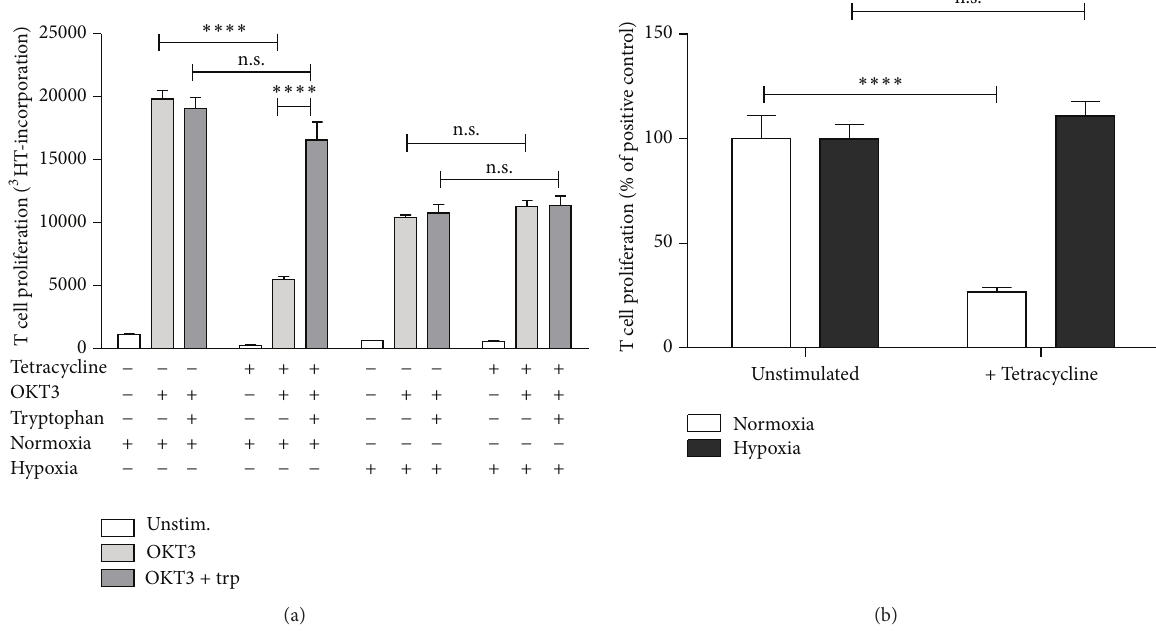
Figure 6: Loss of TDO immunoregulatory function in HeLa-hTDO cells under hypoxic conditions. T cell proliferation experiments: HeLa- hTDO cells were prestimulated with or without tetracycline (10ng/mL) for 72 h under normoxia (20% O 2 ) or hypoxia (1% O 2 ). Then the supernatants were harvested and served as cell culture medium for freshly isolated peripheral blood lymphocytes (PBL). 1.5 × 10 5 PBL/well were activated in 96-well plates with a monoclonal anti-CD3 antibody (OKT3) and T cell proliferation was determined after three days by adding 3 H-thymidine for 24 h. The incorporation of 3 H-thymidine was detected using liquid scintillation spectrometry (1205 Betaplate, PerkinElmer, Rodgau J¨ugesheim, Germany). A significant alteration of T cell proliferation as compared to the respective control group is marked with asterisks ( ∗∗∗∗ 𝑝 ≤ 0.0001 ; n.s. = not significant) and was calculated via a two-tailed, unpaired t -test. (a) Single experiment with three replicates and (b) summary of three independent experiments with three replicates each. The bars indicate the mean value ± SD (a) or ± SEM